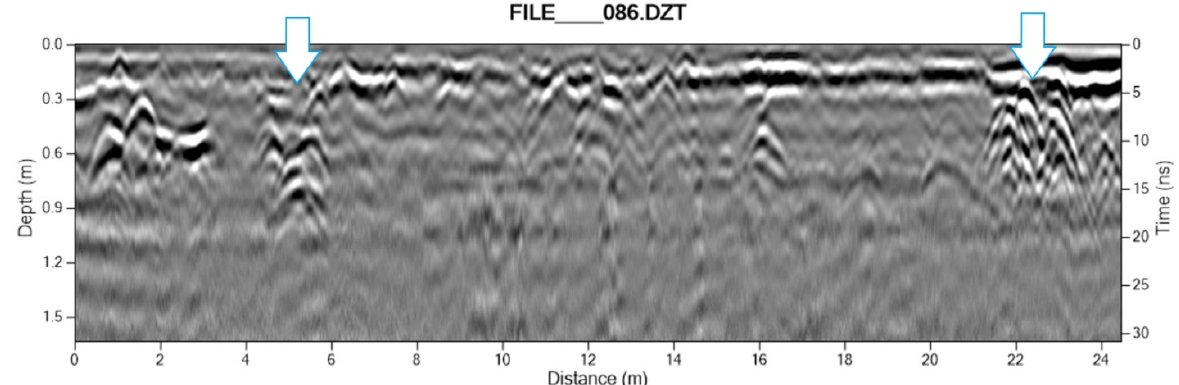
Figure 12. 400 MHz antenna profile of a transect at perpendicular crossings of two adobe walls in the north wing of the Spanish quadrangle at the Sanchez Adobe. The wall at left is interior (adjacent to the chapel) and the wall at right is likely a more robust exterior wall.